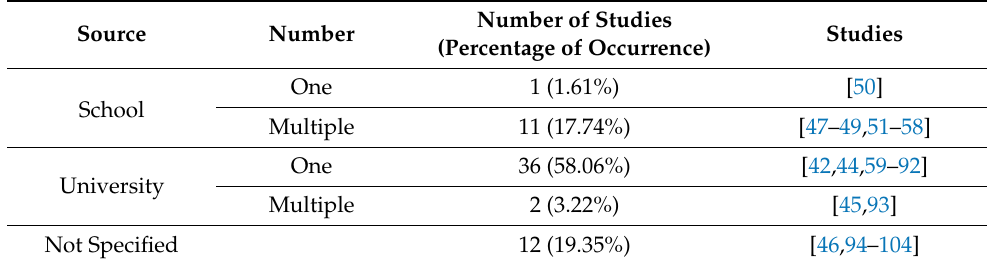
Table 5. Source of educational dataset in the studies.